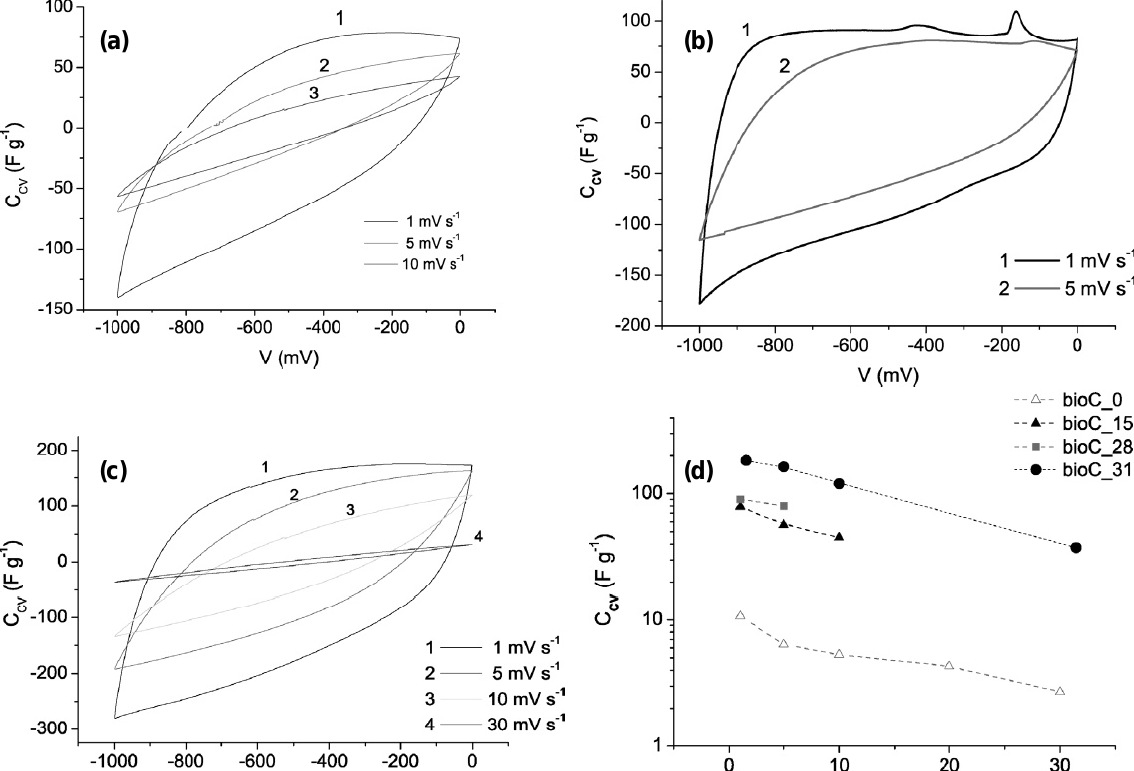
Fig. 6. Cyclic voltammetry curves of monolithic activated biocarbons with a weight loss of (a) 15%, (b) 28% and (c) 31% at different scan rates; (d) dependence of maximum specific capacity on scan rate for mono- lithic biocarbons (1 M KOH